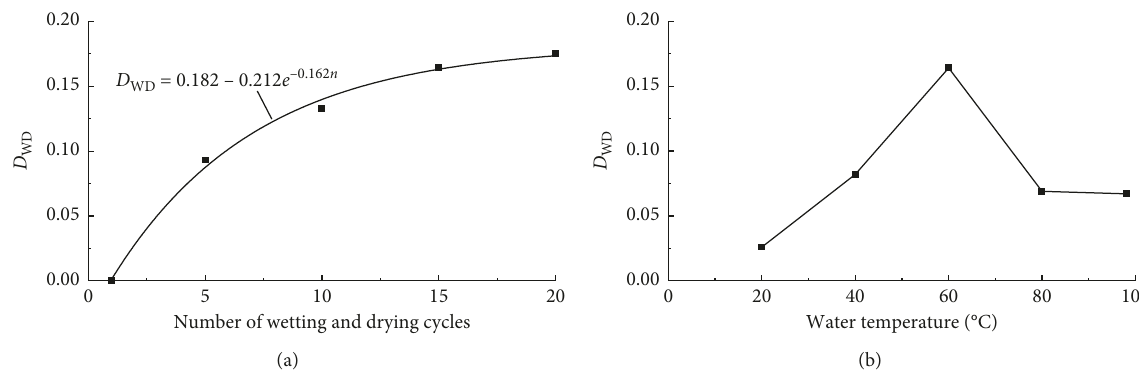
Figure 12: Variation of D WD after cyclic wetting and drying treatment. (a) D WD versus the number of wetting and drying cycles. (b) D WD versus water